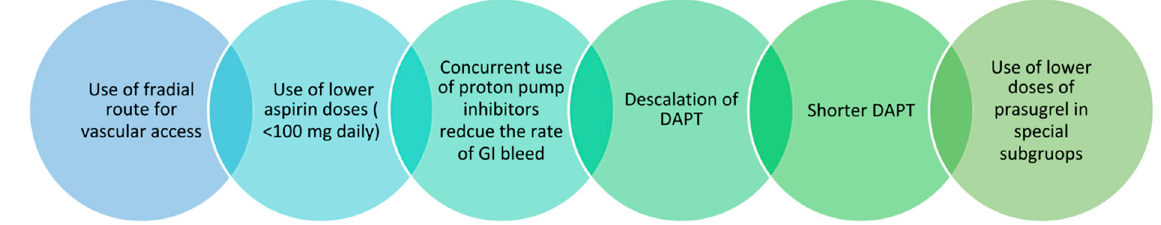
Figure 4. Various methods for mitigation of bleeding with the use of dual antiplatelet therapy (DAPT—dual antiplatelet therapy).